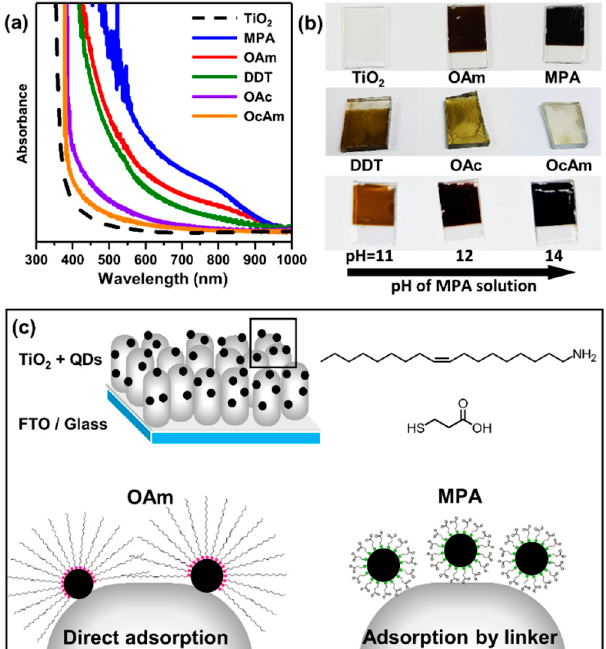
Figure 3. ( a ) Absorption spectra of bare and QD-sensitized TiO 2 films using CISe QDs with various surface ligands. ( b ) Photographs of (top) bare, OAm-, MPA-, (middle) DDT-, OAc-, OcAm- passivated CISe QD-sensitized TiO 2 films, and (bottom) CISe QD-sensitized TiO 2 films made from MPA-passivated QDs as a function of the pH of the QD solution. ( c ) Schematic illustration showing the CISe QD-sensitized TiO 2 film and the two different adsorption mechanisms of